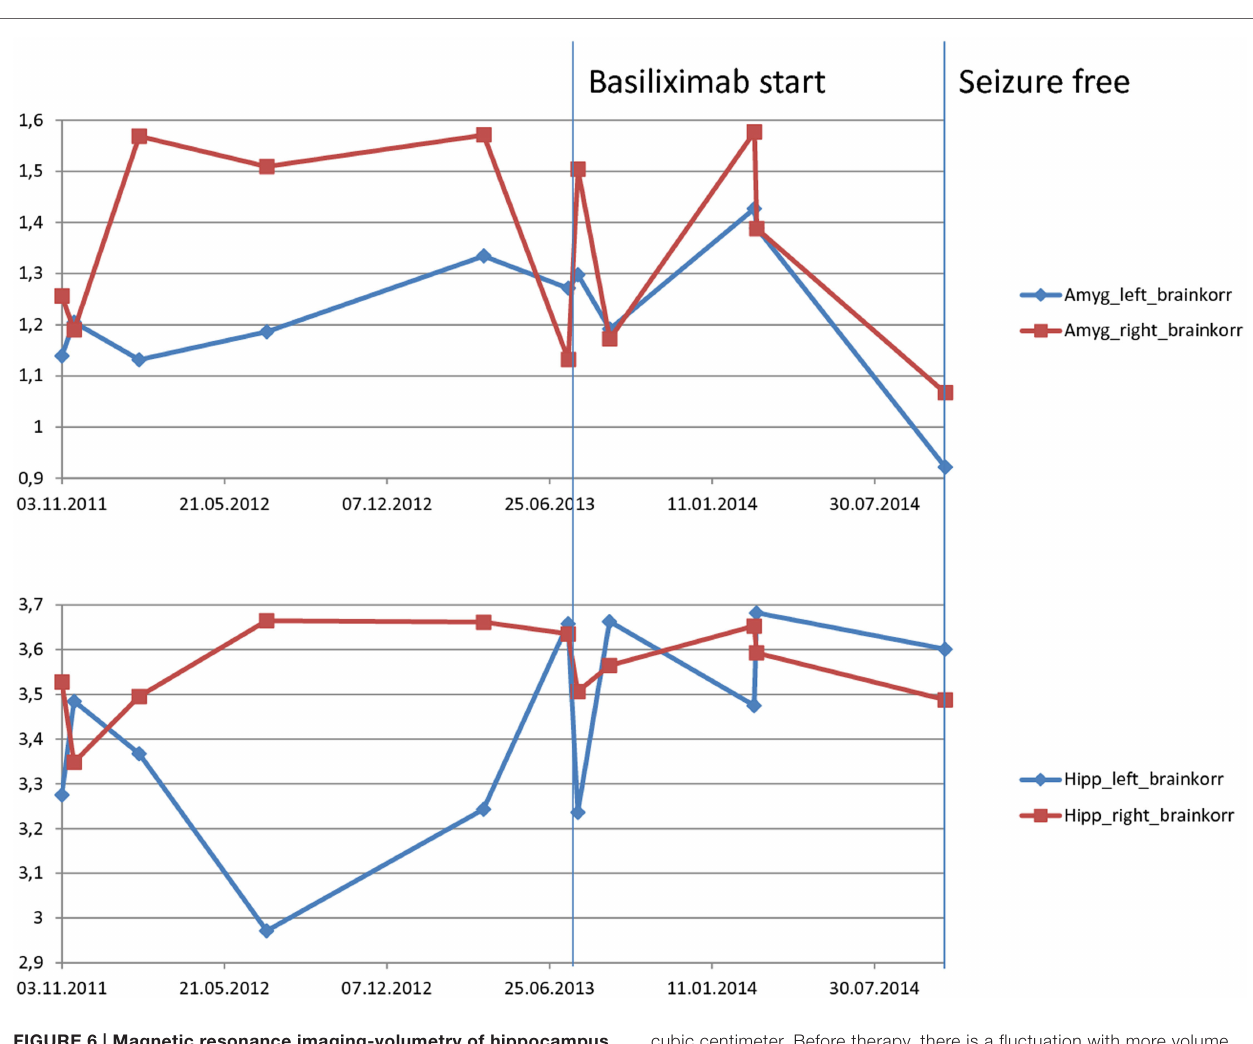
cubic centimeter. Before therapy, there is a fluctuation with more volume of right temporomesial structures. Last volumetry, acquired during the period without seizures shows a consensual volume-decrease in both